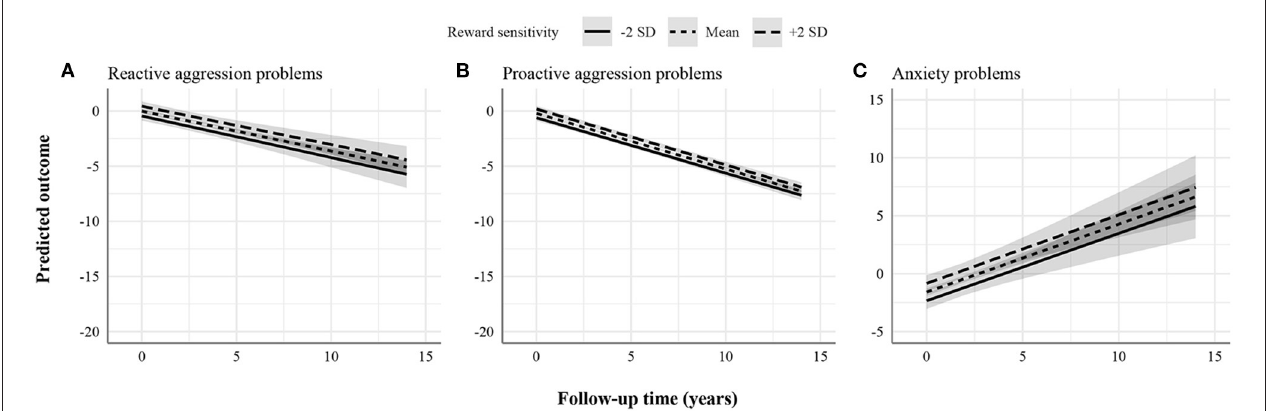
FIGURE 1 | Statistically significant stable associations between reward sensitivity and psychopathology domains. (A) Reactive aggression problems. (B) Proactive aggression problems. (C) Anxiety problems. The figures display the effect of reward sensitivity on psychopathology based on its main effect and in interaction with time. Here, the x-axes show follow-up time in years, whereas the different lines show reward sensitivity levels at 2 SD above and below the mean. The y-axes represent the predicted outcome with all covariates at mean levels and sex coded as 0 (males). The y-axes are only partly shown for better visualization of the